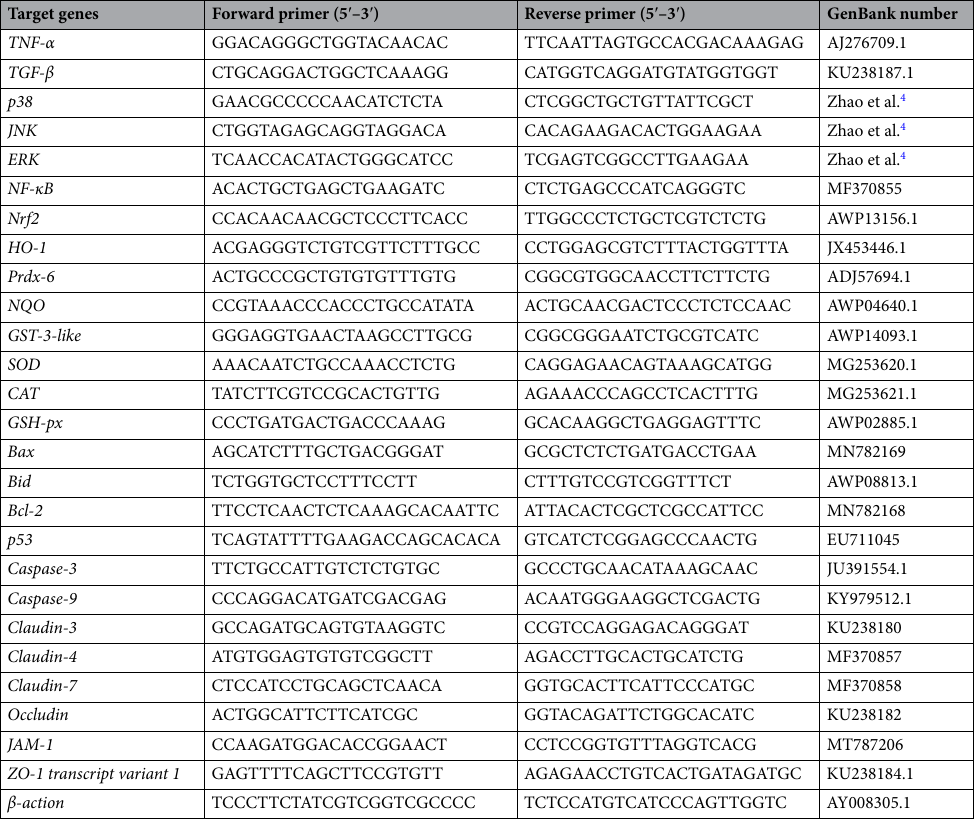
Table 3. Primers. ZO-1 zonula occludens-1, TNF-α tumor necrosis factor-α, p38 p38 mitogen-activated protein kinase, TGF-β transforming growth factor-β, JNK c-Jun N-terminal kinase, ERK extracellular regulated kinase, NF-κB nuclear transcription factor-kappa B, Nrf2 Nuclear factor E2 -related factor 2, HO-1 heme oxygenase-1, JAM-1 Junctional adhesion molecules-1, Prdx-6 Peroxiredoxin-6, NQO NAD(P)H quinone oxidoreductase, GST-3-like glutathione- S -transferase-3-like, SOD superoxide dismutase, CAT catalase, GSH-Px glutathione